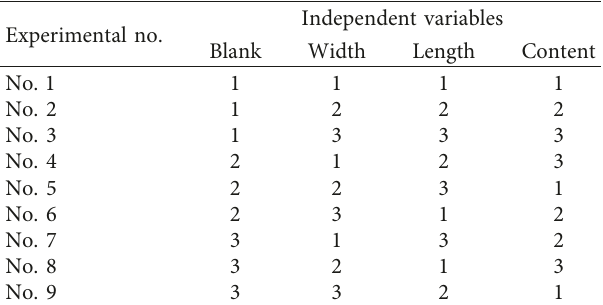
9 orthogonal array.